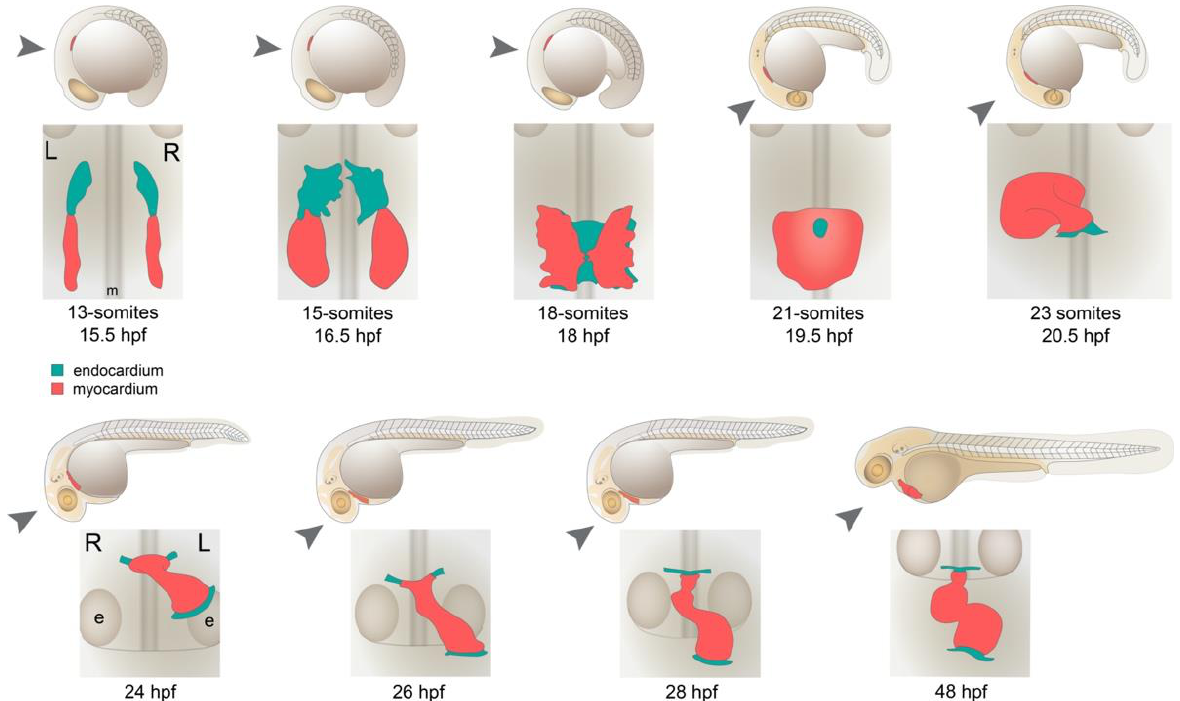
Figure 2. Heart morphogenesis in the zebrafish embryo. Embryonic stages depicted above, with view of heart fields underneath (point of view for heart fields depicted with grey arrow). Endocardial, followed by myocardial, progenitors differentiate in the ALPM by 13 s (15.5 hpf) as bilateral populations. Endocardial cells migrate medially and then caudally to fuse at the midline between the myocardia. The myocardium (comprising cardiomyocytes) then fuses at the midline, encapsulating the endocardium. Between 19 and 26 hpf, the heart undergoes a complex reorganisation, elongating the disc to a tube, where the edges of the cardiac disc reposition under the left eye of the embryo. From 26 hpf, the tube moves back towards the midline and extends anteriorly, positioning the heart over the yolk, between the eyes. The future ventricular chamber realigns to the right and the heart loops, forming an S-shape by 48 hpf. Embryonic midline (m) and eyes (e) depicted to provide anatomical